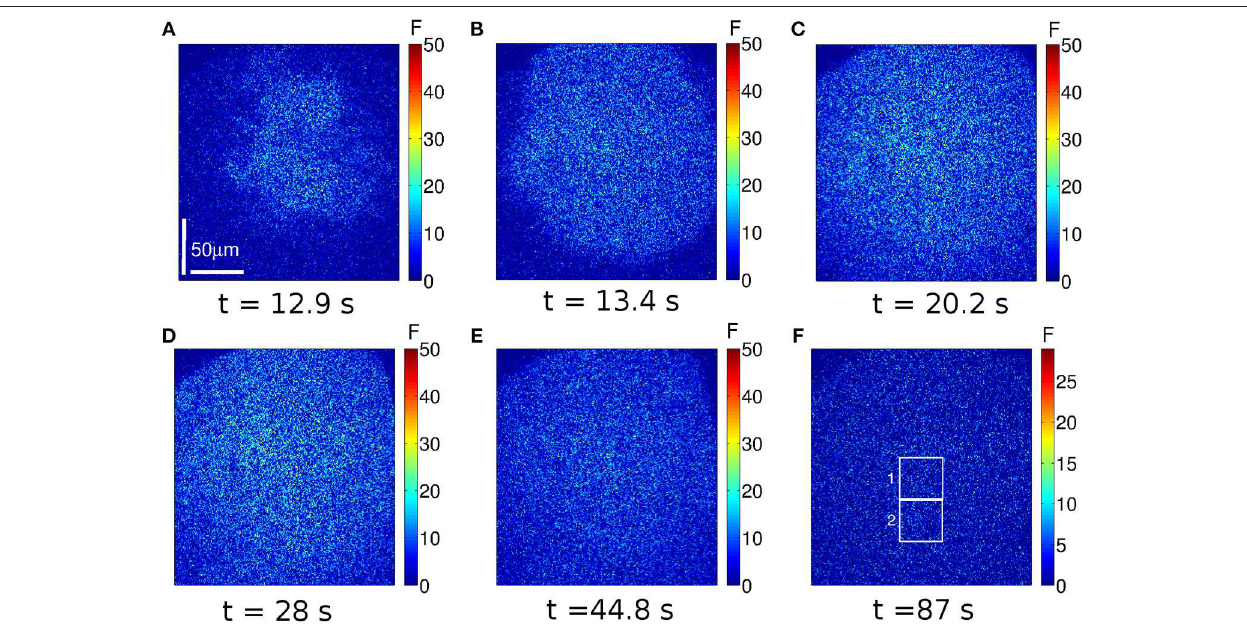
FIGURE 3 | Example of a Ca 2 + signal evoked in an egg. Similar to Figure 2 , but for an experiment performed in an egg. In this case the UV illumination was on between t 11.2 s and t 28 s and between t 112 s and t 128.8 s. At t 12.9 s the Ca 2 + release becomes apparent (A) . The Ca 2 + distribution is more = = = = ∼ spatially uniform than in the oocyte. The wave propagates (B,C) and the fluorescence keeps on increasing while the UV light is on (D) . Approximately 16 s after the UV flash is turned off ( t 44.8 s), the fluorescence has not reached the basal level yet (E) . Ca 2 + puffs are not observed in between the two UV flashes (F) . The white = boxes indicate two regions analyzed in Figure 4